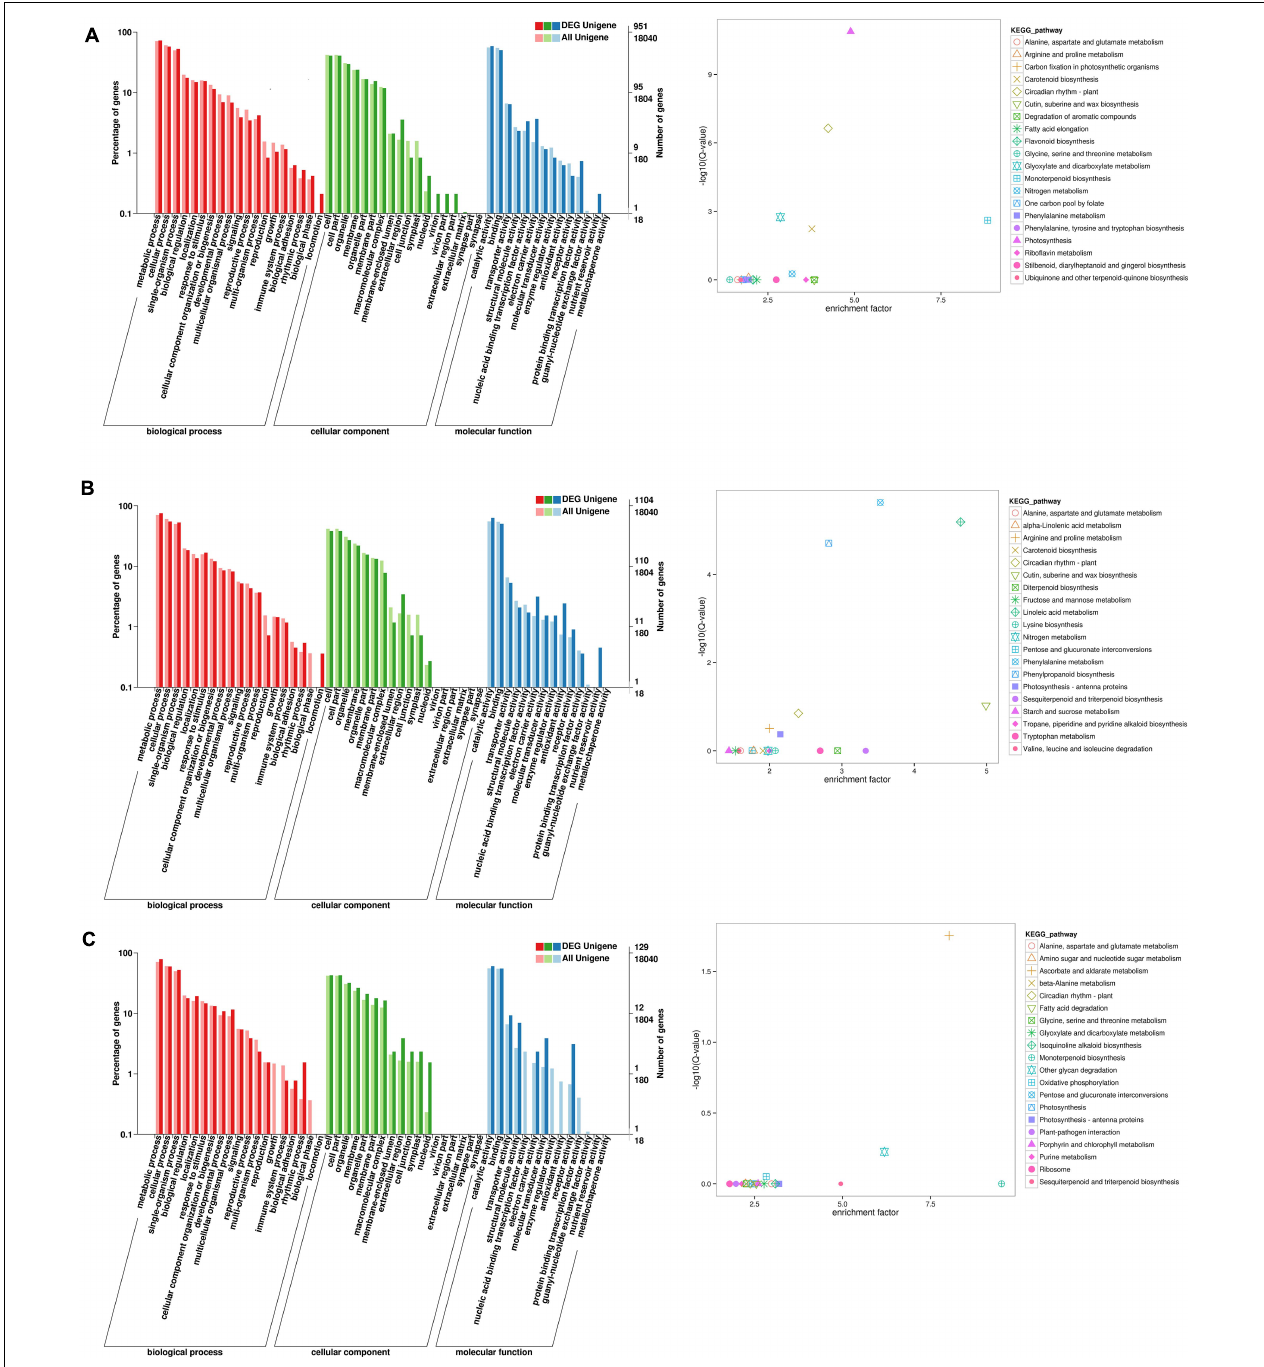
FIGURE 3 | GO and KEGG enrichment analyses of DEGs (move to Appendix). (A) GO and KEGG enrichment analyses of DEGs between cold treated dark cultured and incubators cultured faba bean buds. (B) GO and KEGG enrichment analyses of DEGs between cold treated dark cultured faba bean buds and control. (C) GO and KEGG enrichment analyses of DEGs between cold treated dark cultured then transferred to incubators and incubators cultured faba bean buds.